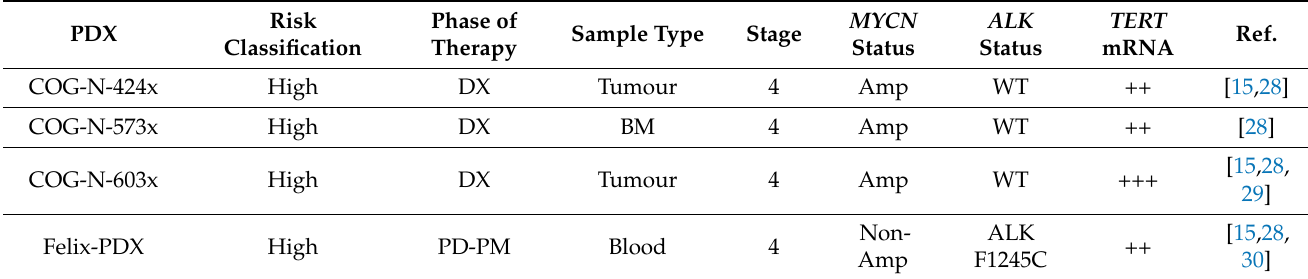
Table 1. Characteristics of NB PDXs